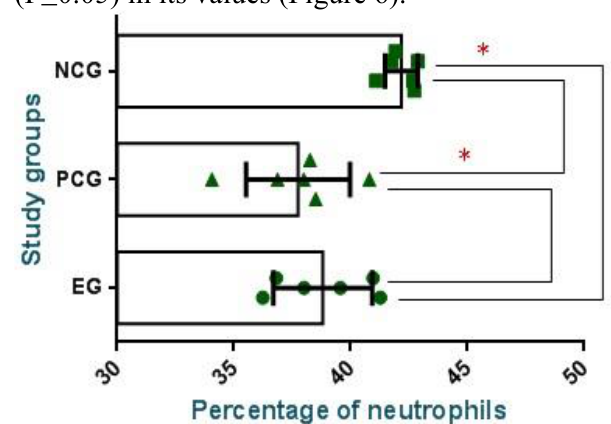
Figure 6. Total results of neutrophils among the experimental groups and the time points. (*) referred to significant differences between groups as P≤0.05.